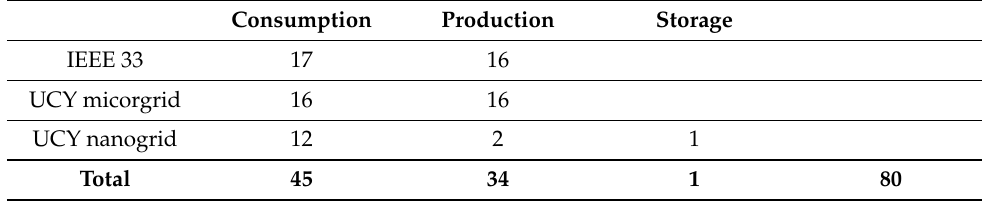
Table 5. Total number of assets used in the investigated model.